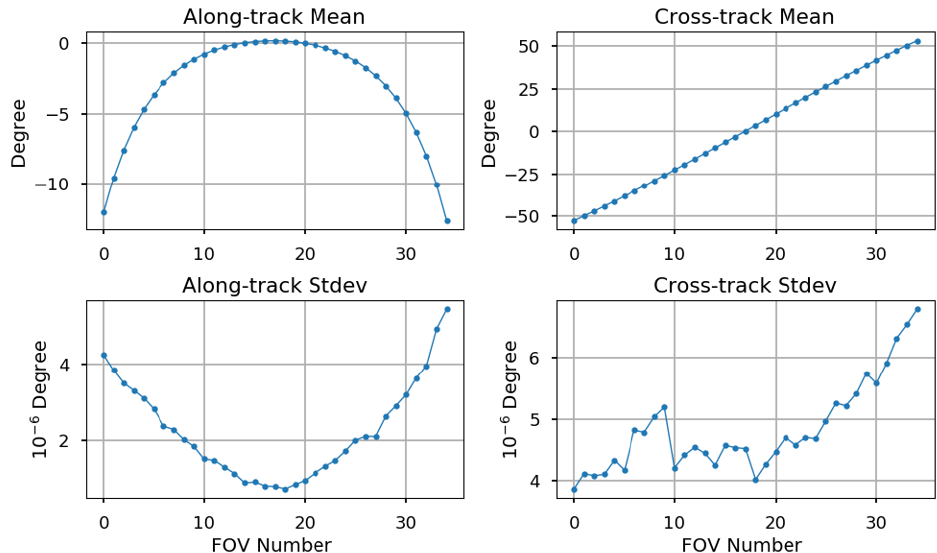
Figure 7. The along-track ( left ) and cross-track ( right ) angles in the S/C coordinate computed for the granule shown in Figure 1a, which contains 150 scanlines. The mean and standard deviations are given at the top and bottom, respectively.